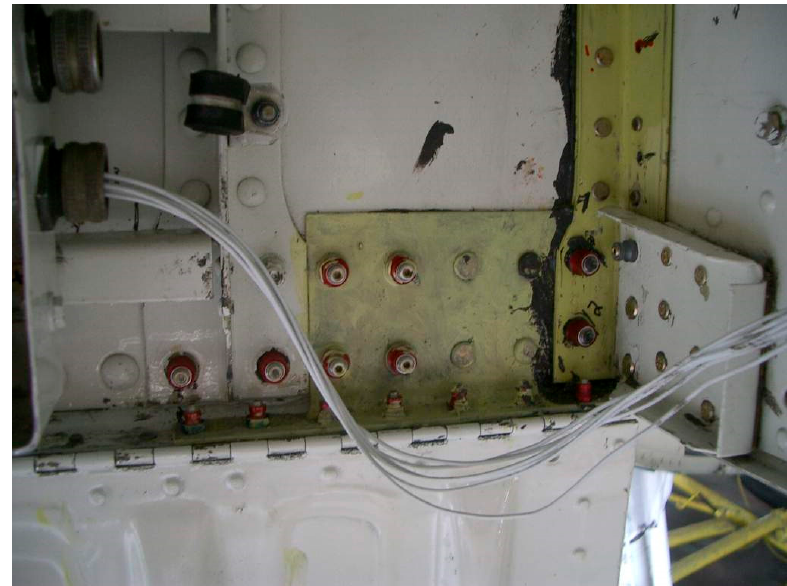
Figure 1. CP140 Critical Point 16 inboard engine nacelle skate angle.